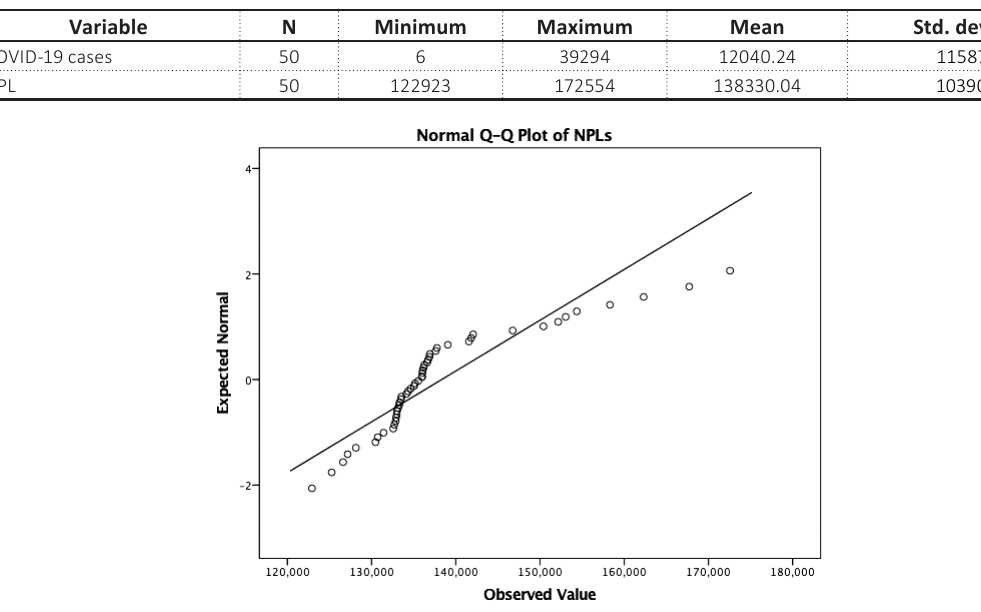
Figure 1. Data normality